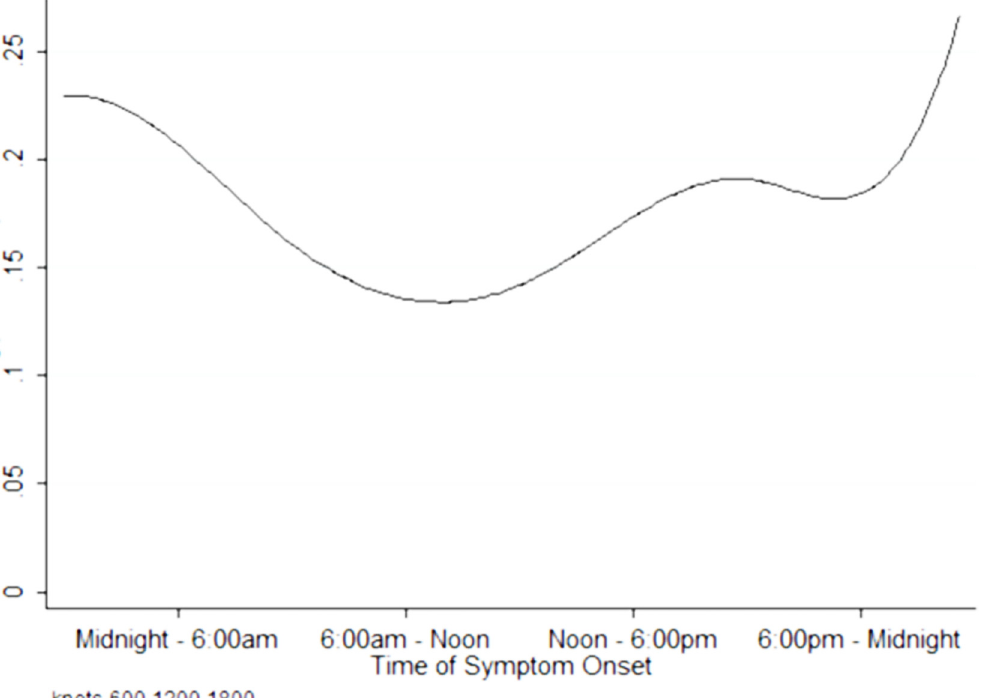
Fig 4. Fitted curve of Peak concentration of log (CK) against time of symptom onset. Non-linear B-splines with 3 internal knots (turning points) between 3:00AM – 6:00AM, 6:00AM – 9:00AM and 6:00PM — 9:00PM, centering on mean log peak CK, to assess any potential non-linear relationship between the exposure (time of symptom onset) and outcome of interest (infarct